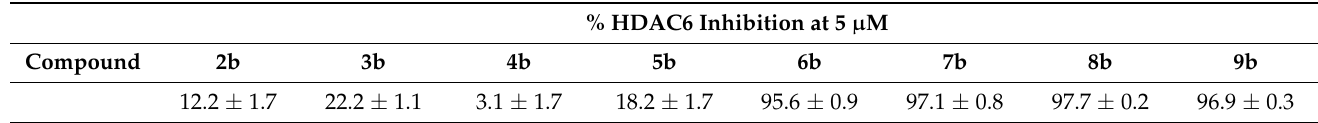
Table 1. HDAC6 inhibition data for 2b to 9b .